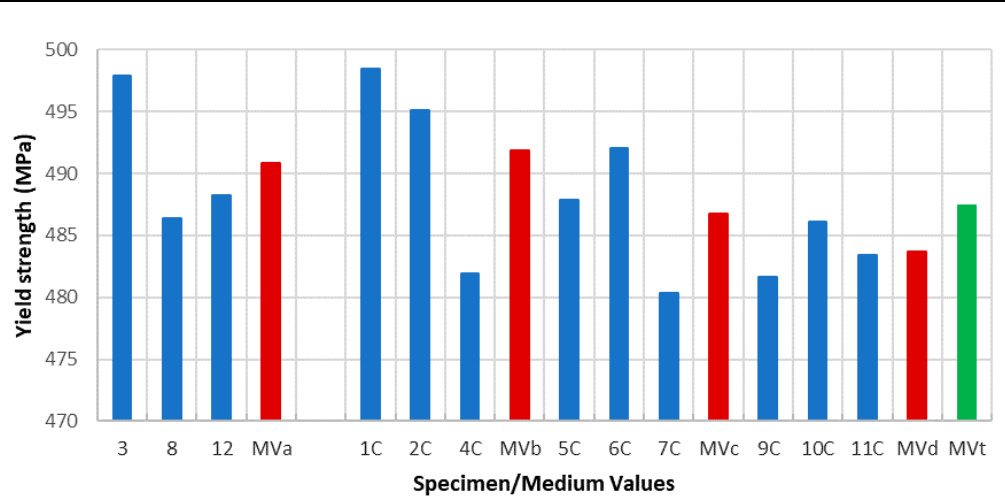
Figure 6. Yield strength vs. specimen and medium values.